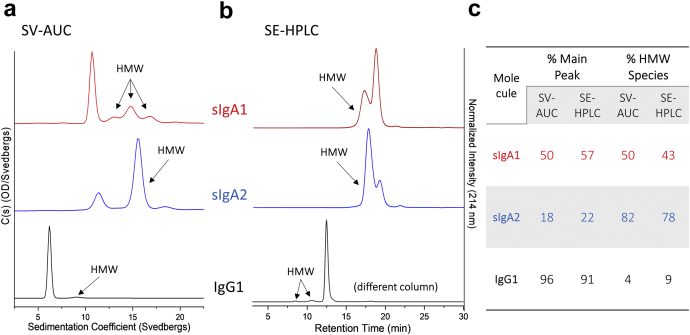
Size analysis of anti-LT sIgA1, sIgA2, and IgG1 mAbs as measured by SV-AVC and SE-HPLC. (a) Representative SV-AUC and (b) representative SE-HPLC analysis of the 3 mAbs. Two major categories (main peak and HMW species) were assigned based on sedimentation coefficient values and retention time values, respectively. Note, a different SEC column was used for IgG1 versus the 2 sIgAs mAbs. (c) Relative amount of main peak and HMW species calculated based on the total peak areas for both SV-AUC and SE-HPLC. Estimated molecular weight determinations were calculated as shown in Supplemental Table S1. Percent species were determined as average value; n = 2 for SV-AUC and n = 3 for SE-HPLC, with range and standard deviation values of 0.1% to 4.4% and from 0.1% to 0.6%, respectively.